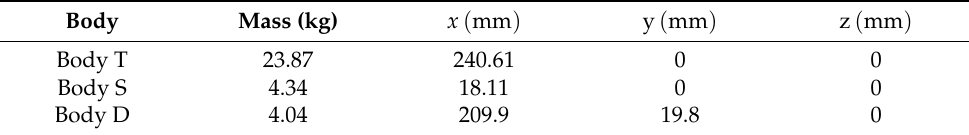
Table 2. Mass and mass center locations of the three rigid bodies.